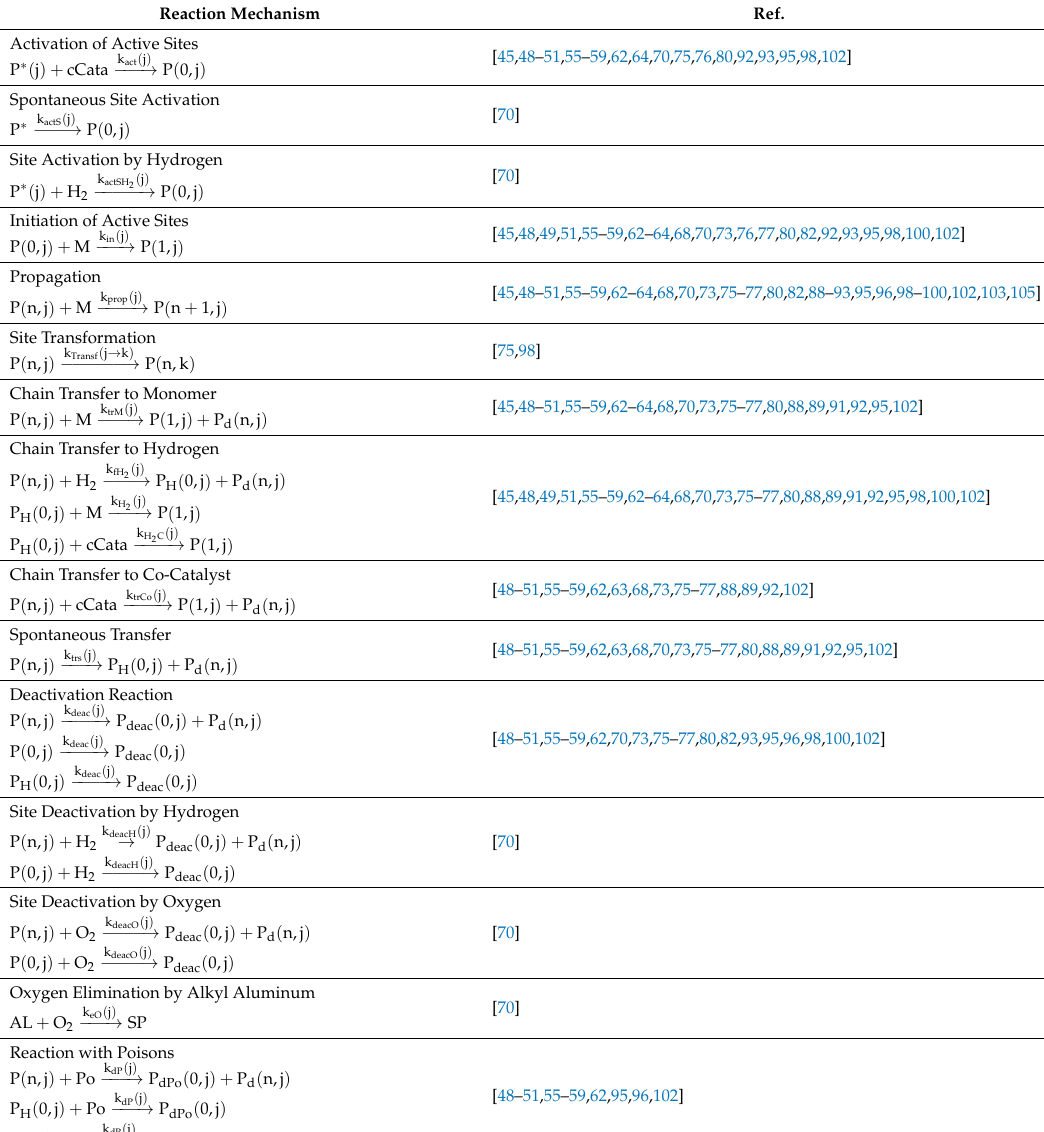
Table 3. Mechanism of the reaction for the coordination mechanism by using the organometallic catalyst. Reaction